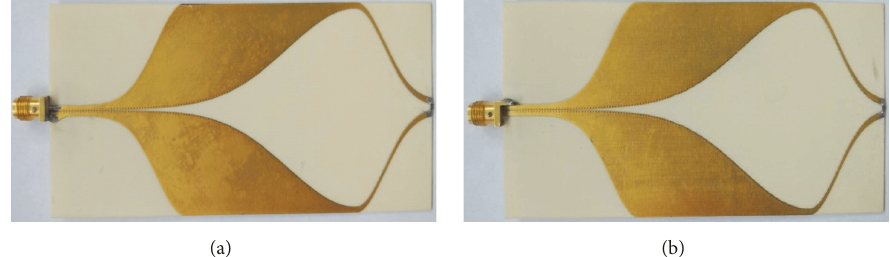
Figure 3: Photos of the proposed antenna. (a) Top side and (b) bottom side. 𝑙 = 112 mm, 𝑤 = 53.4 mm, 𝑙 1 = 84 mm, 𝑙 2 = 23 mm, 𝑅 = 200 Ohm, 𝜏 = 99.2 , and 𝜏 = 42.4 1 2